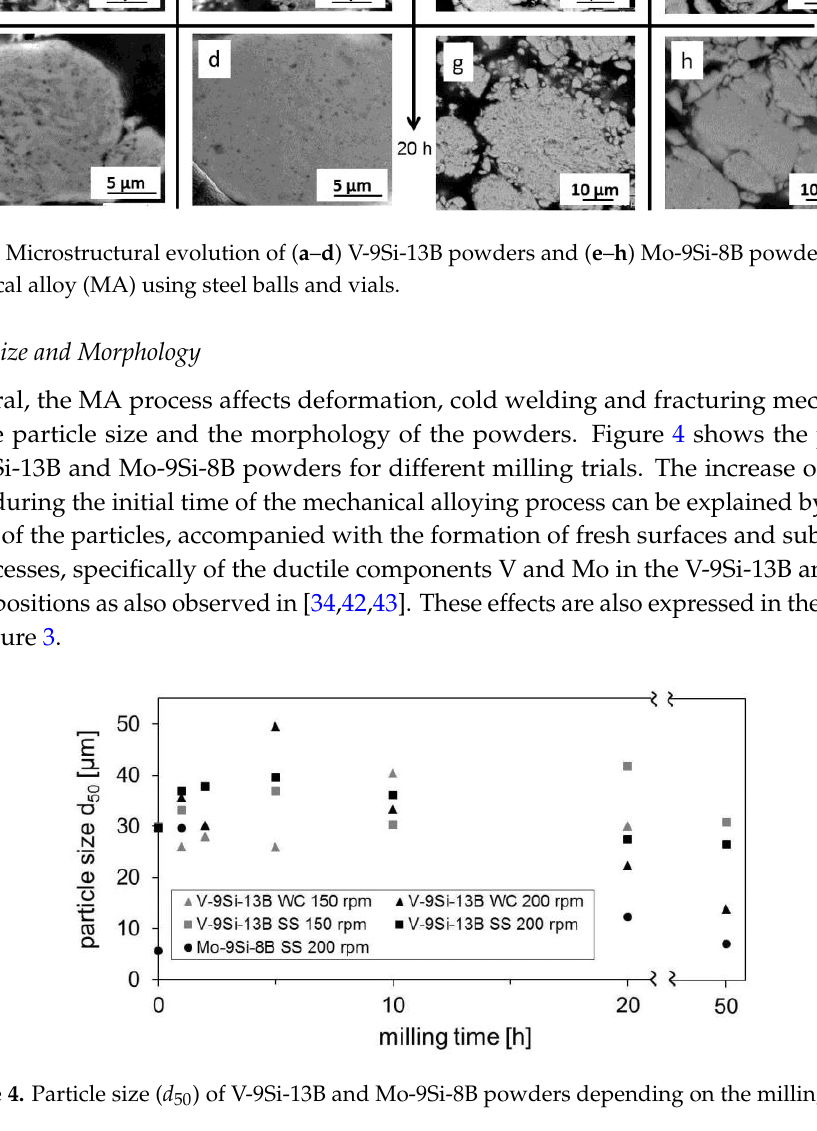
Figure 3. Microstructural evolution of ( a – d ) V-9Si-13B powders and ( e – h ) Mo-9Si-8B powders during mechanical alloy (MA) using steel balls and vials.